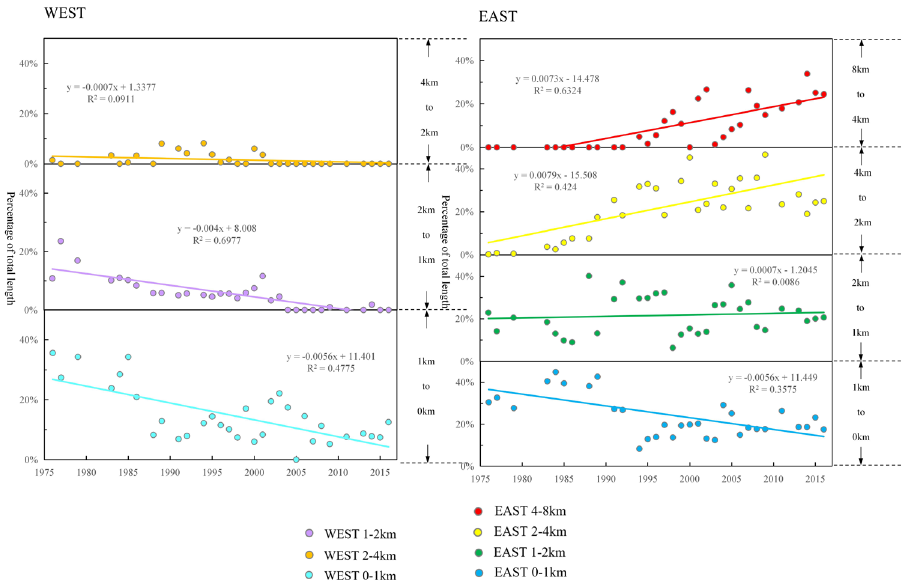
Figure 10. Overlay analysis of sand ridgelines buffer zone.